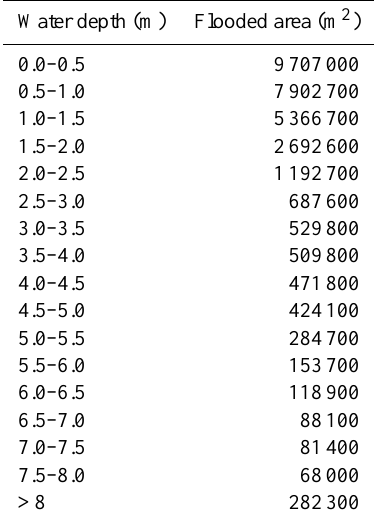
Table 4. Flooded area for the different categories of water depth, H .